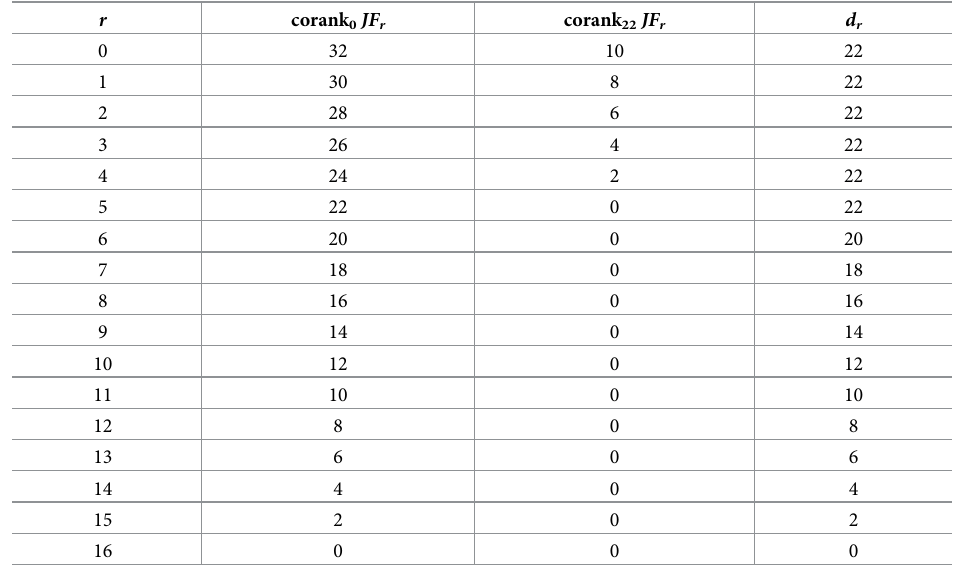
Table 8. Summary of computations showing model is identifiable.